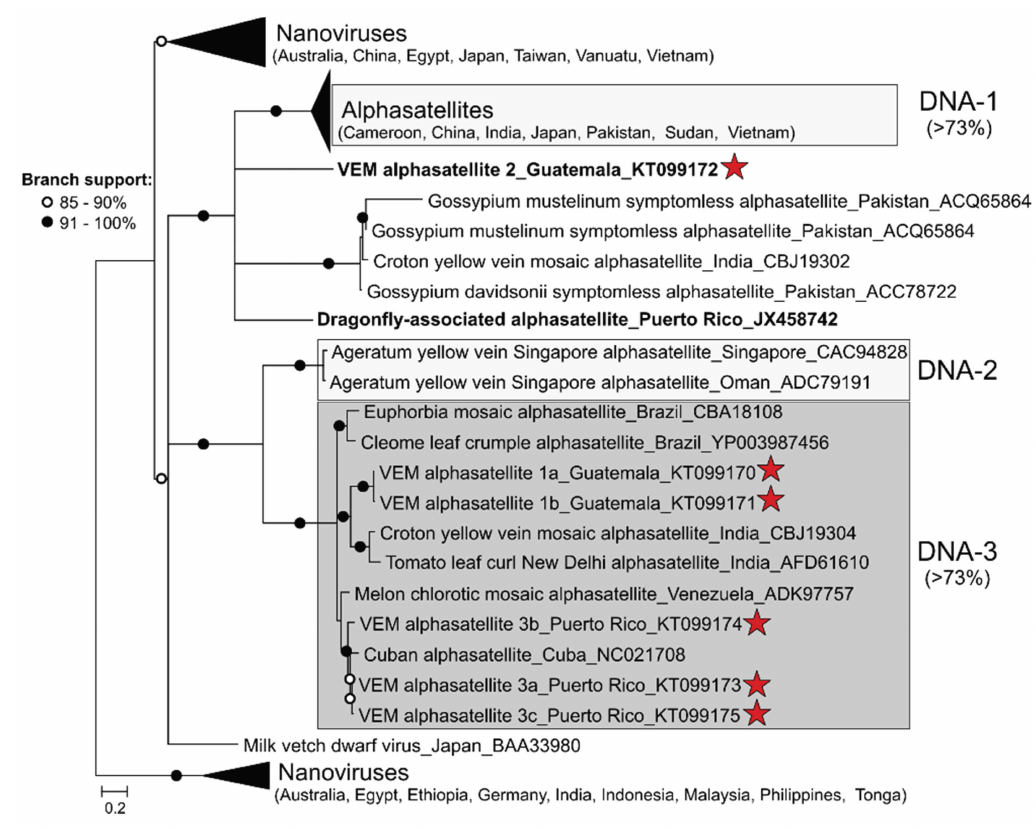
Figure 2. Midpoint-rooted maximum likelihood phylogenetic tree of predicted alphasatellite and nanovirus replication-associated protein sequences. Alphasatellites detected during this study are highlighted with a red star. Three groups of alphasatellites based on amino acid pairwise-identities are highlighted in shades of grey, including DNA-1-type alphasatellites from the Old World, DNA-2-type, and DNA-3-type alphasatellites mainly identified in the New World. Branches exhibiting less than 70% branch support were collapsed. Branches with approximate likelihood ratio test (aLRT) support > 91% are indicated with black circles, whereas branches exhibiting 85%–90% support are marked with a white circle. A list of sequences used for phylogenetic analysis and Rep pairwise identities are provided in Supplemental File